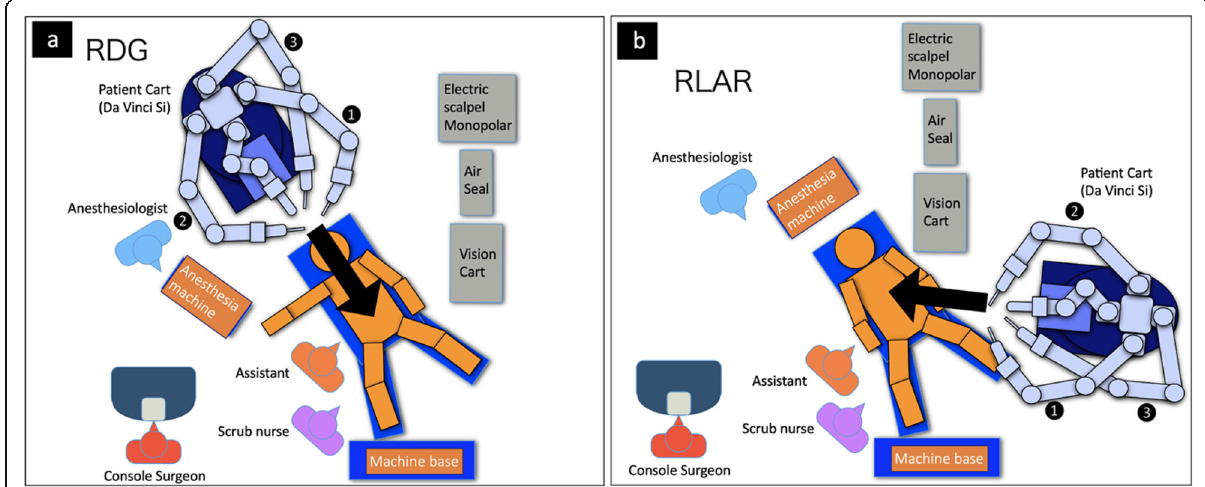
Fig. 5 Operating room settings. a Operating room settings for robotic distal gastrectomy (RDG). The anesthesia machine was placed on the right side of the patient, and the patient cart was rolled from the patient ’ s head side. b Operating room settings for robotic low anterior resection (RLAR). The patient cart was moved to the caudal side through the left bedside space. The anesthesia machine was placed on the patient ’ s head side, and the patient cart was rolled from the left foot side of the patient. To count the number of surgeries, we only moved without turning off the power of the